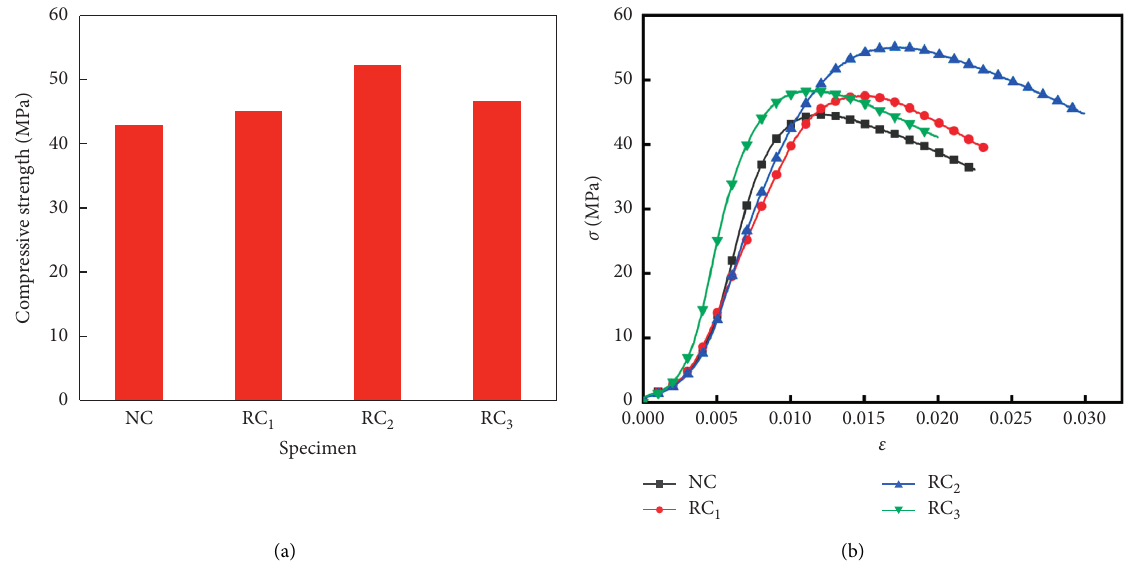
Figure 1: Test results. (a) Compressive strength. (b) Stress-strain curves.